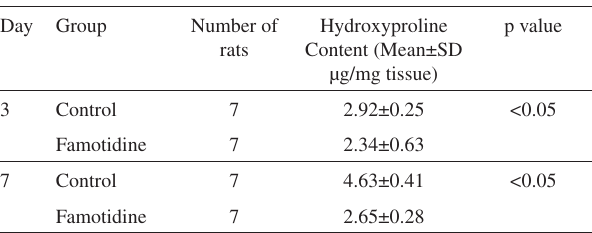
Table 2 - Mean hydroxyproline contents of the Control and Famotidine